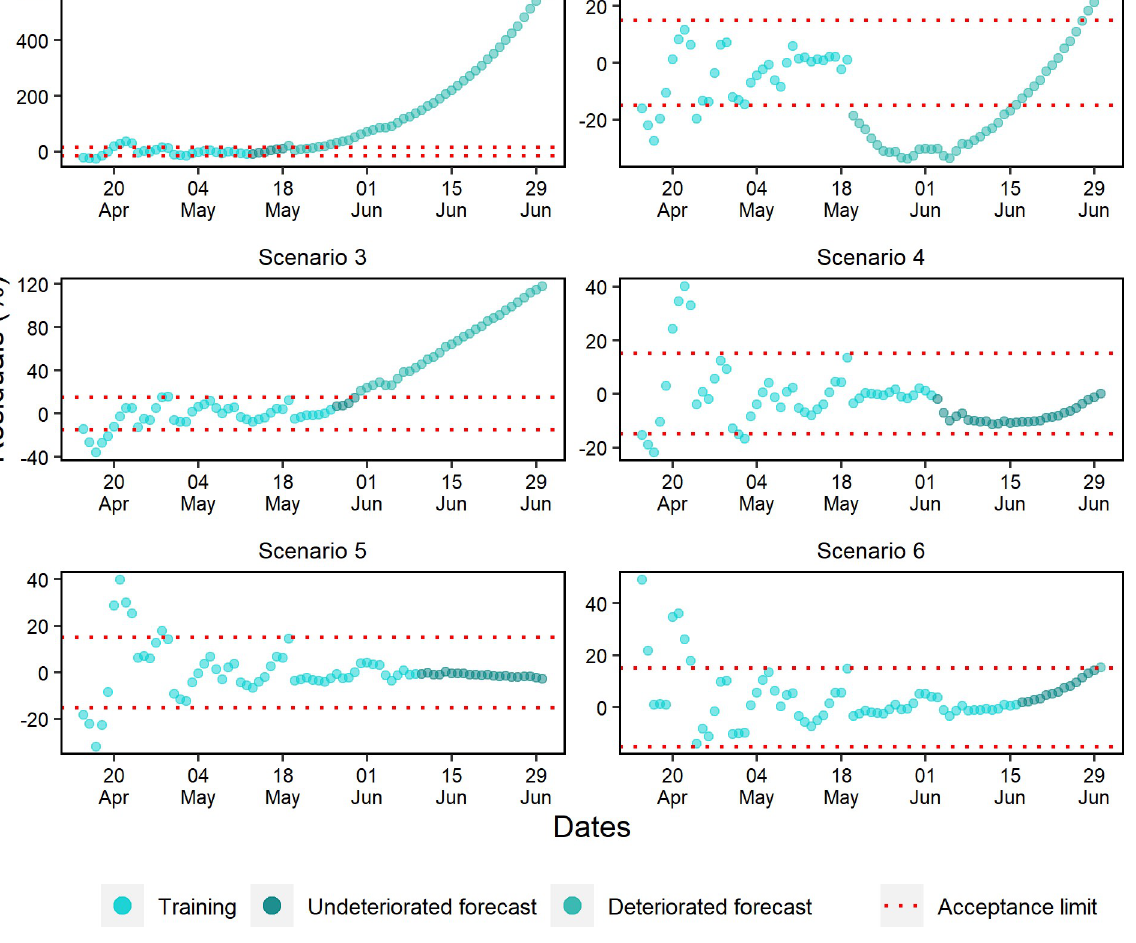
Fig 11. Percentual residuals for cumulative deaths of the 6 analyzed